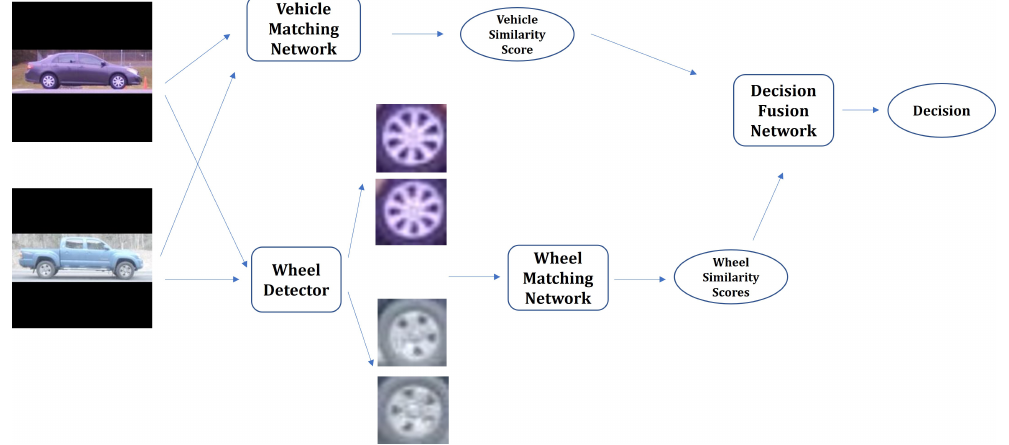
Figure 2. Diagram of overall vehicle matching